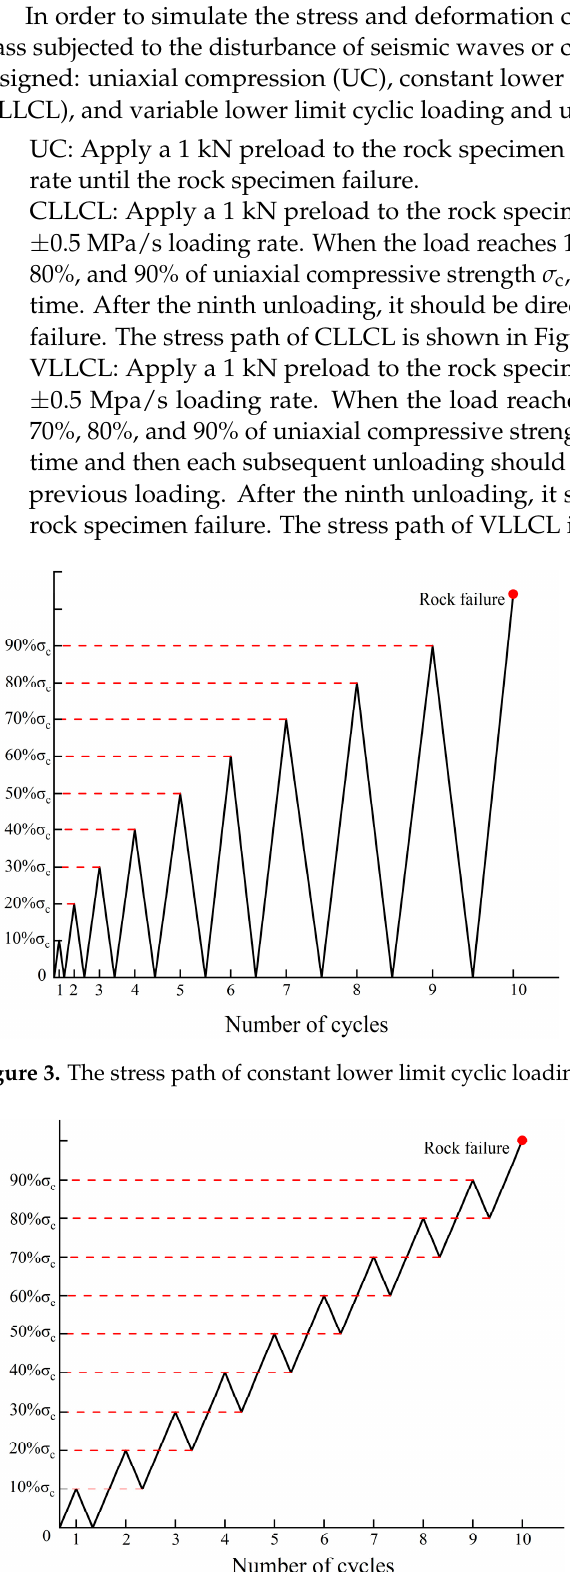
Figure 2. Schematic diagram of testing.